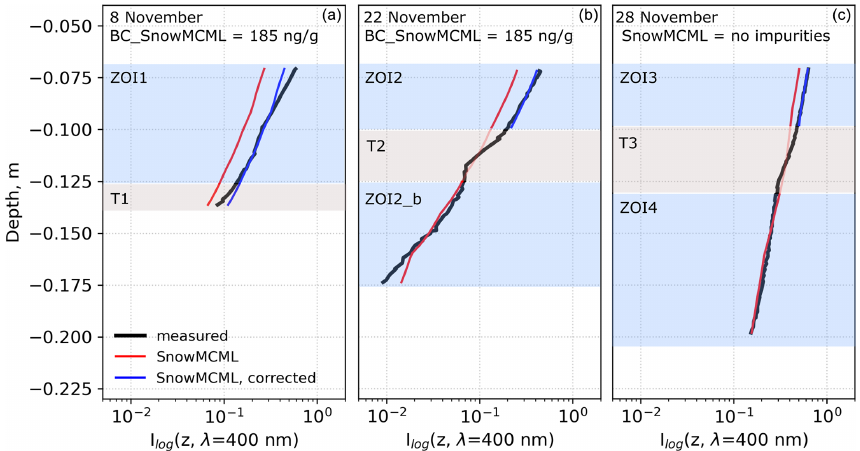
Figure 5. Measured log-irradiance profiles (black curves) and SnowMCML simulations (red and blue curves) for snowpacks without shrubs at 400nm. Simulated profiles were computed assuming black carbon (BC) as the impurity type. Log-irradiance profiles were measured on (a) 8 November, (b) 22 November and (c) 28 November. Grey shaded areas highlight transition zones, where simulated and measured profiles were not expected to fit. Blue shaded areas highlight non-transition zones where the fit between simulated and measured profiles allowed the determination of impurity concentrations. A constant correction factor was applied to the simulated data in those layers where the extinction gradients were similar to the measured values but the profiles were parallel instead of overlapping. Correction factors were 0.61 (a, b) and 0.8 (c)